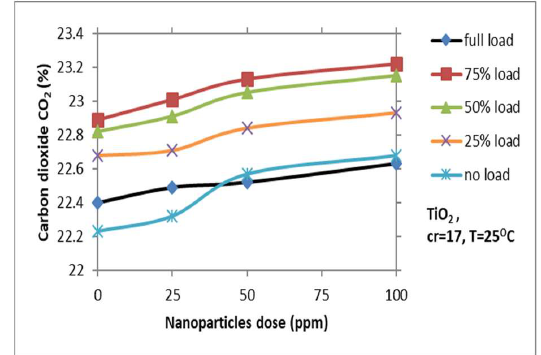
Fig. 5. Variation of Nitrogen Oxide Emissions (NOx) with Alumina nanoparticles doses.